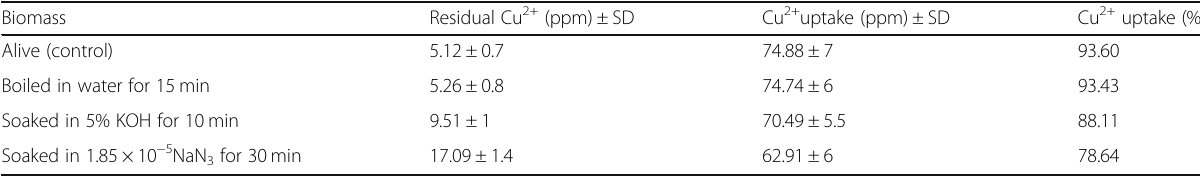
Table 1 Cu 2+ uptake by alive and dead Aspergillus tamarii NRC 3 biomass Biomass